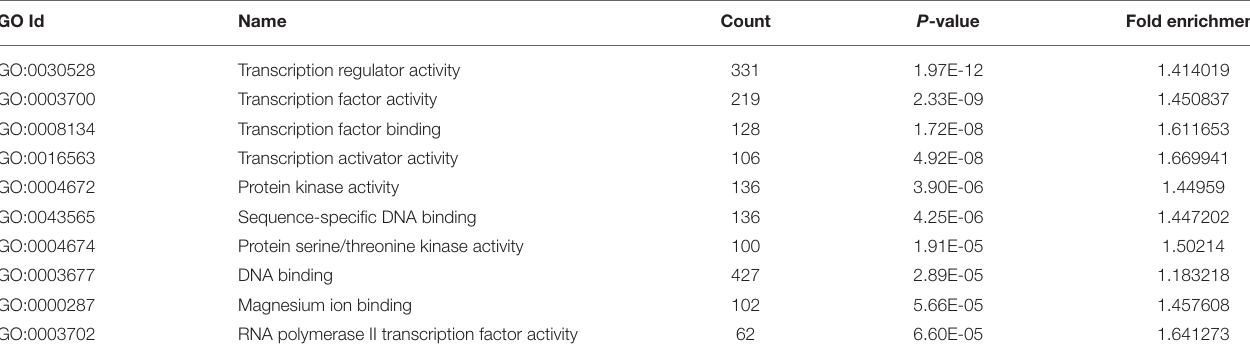
TABLE 1 | GO analysis of the predicted targets of differentially expressed miRNAs a .